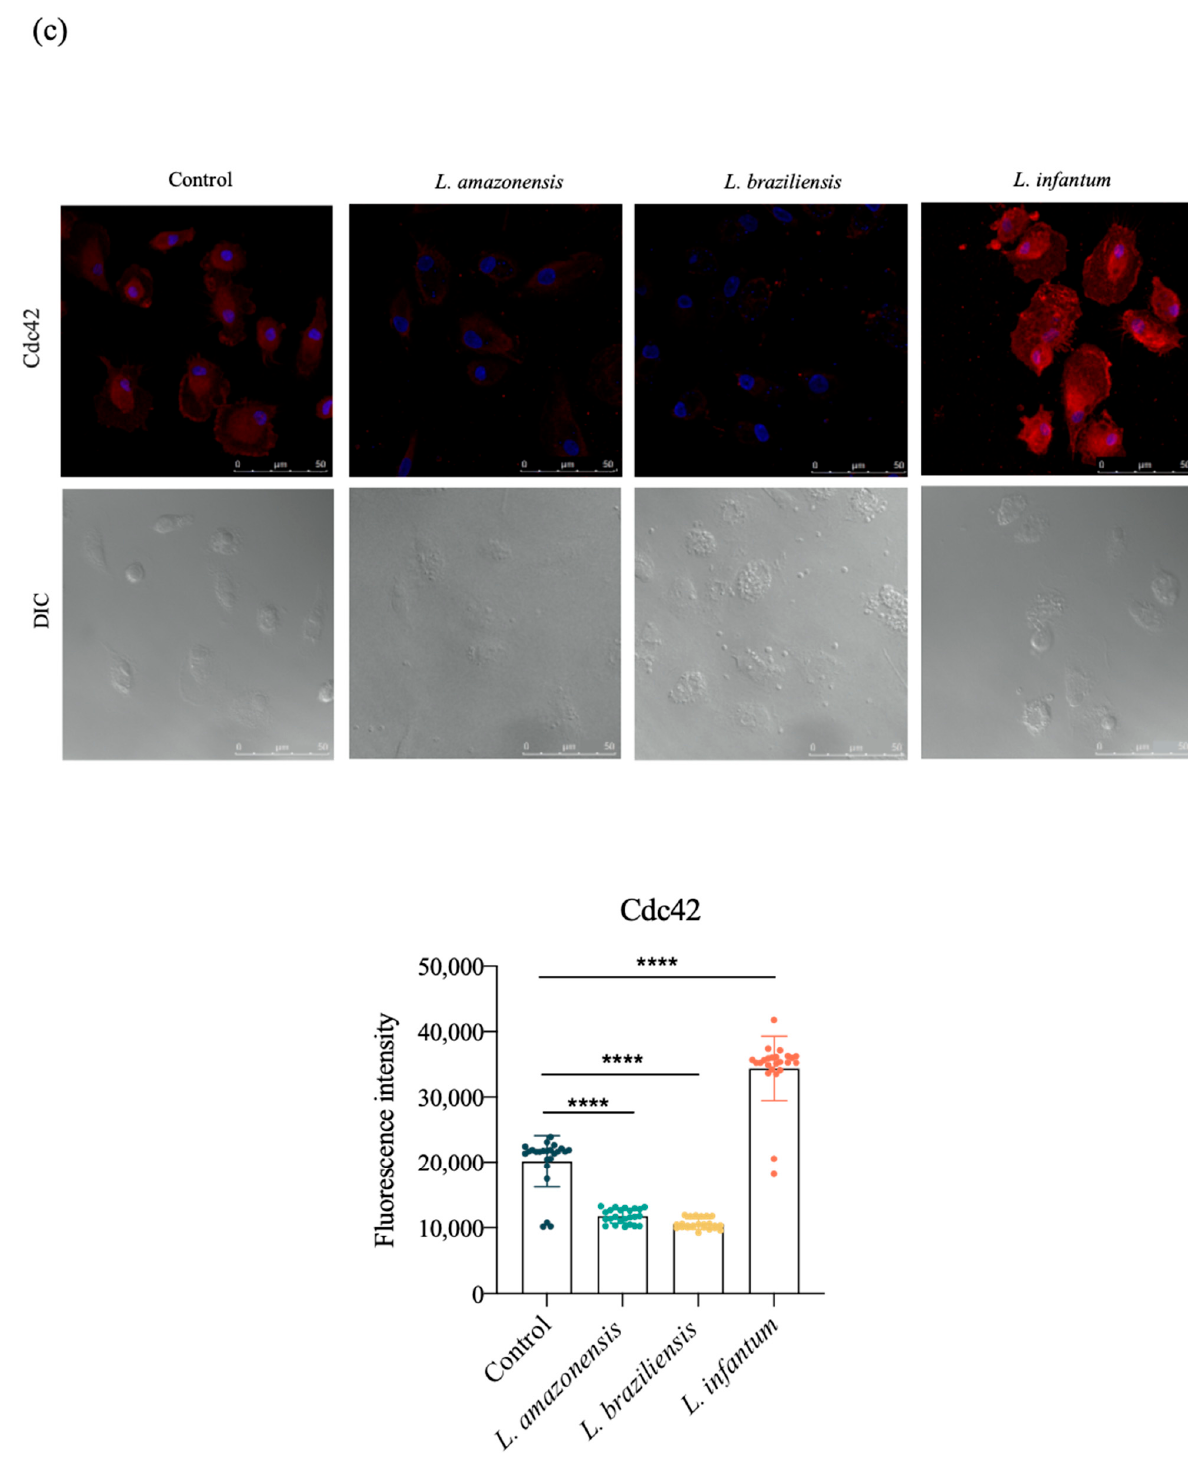
Figure 4. L. infantum infection induces actin polymerization in hDC. Effects of Leishmania infection on Rac1, RhoA, and Cdc42 protein levels in hDCs infected or not with L. amazonensis , L. braziliensis or L. infantum . ( a ) Fluorescence intensity of phalloidin labeling in hDCs infected with L. amazonensis , L. braziliensis or L. infantum . ( b ) Fluorescence intensity of Rac1 and RhoA after L. amazonensis , L. braziliensis or L. infantum infection. ( c ) Fluorescence intensity of Cdc42 in hDCs infected with L. amazonensis , L. braziliensis or L. infantum . Fluorescence intensity quantified in 30 cells from each group. Red: anti-Rac1, anti-RhoA or anti-Cdc42; blue: DAPI, cell nuclei; grayscale: DIC; Control, uninfected cells; white arrowheads: actin bundles. **** p < 0.001 (Student’s t -test). The data are representative of three independent